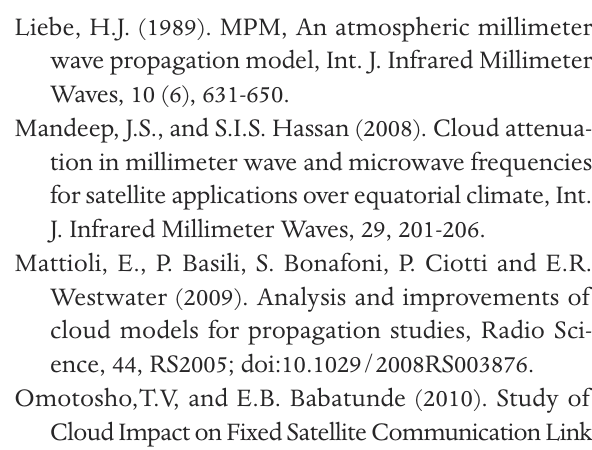
Figure 10. Cumulative distribution of cloud attenuation at 30 GHz obtained from radiosonde measurements. Also shown is the data obtained from the ITU-R model for the six major climatic zones of